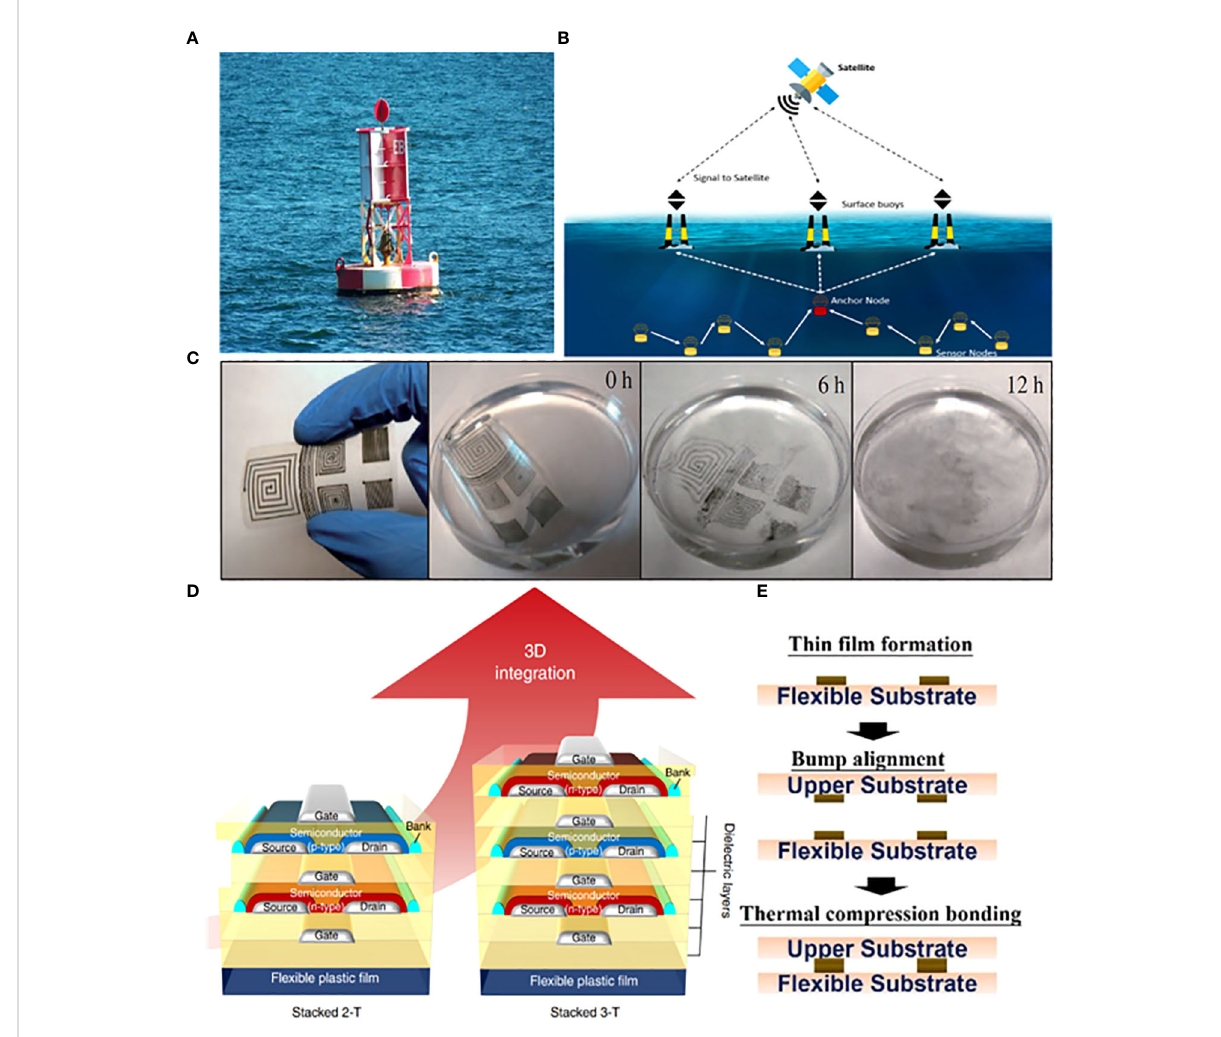
FIGURE 1 Marine electronic devices and advanced electronic technology (A) ocean buoy (B) Underwater sensor network (Shams et al., 2021) (C) Dissolution process of transient electronic in water (Mahajan et al., 2018) (D) 3D monolithic integration in fl exible printed transistors (Kwon et al., 2019) (E) A Novel bonding method based on metal fi lm (Hu and Chen, 2016 )